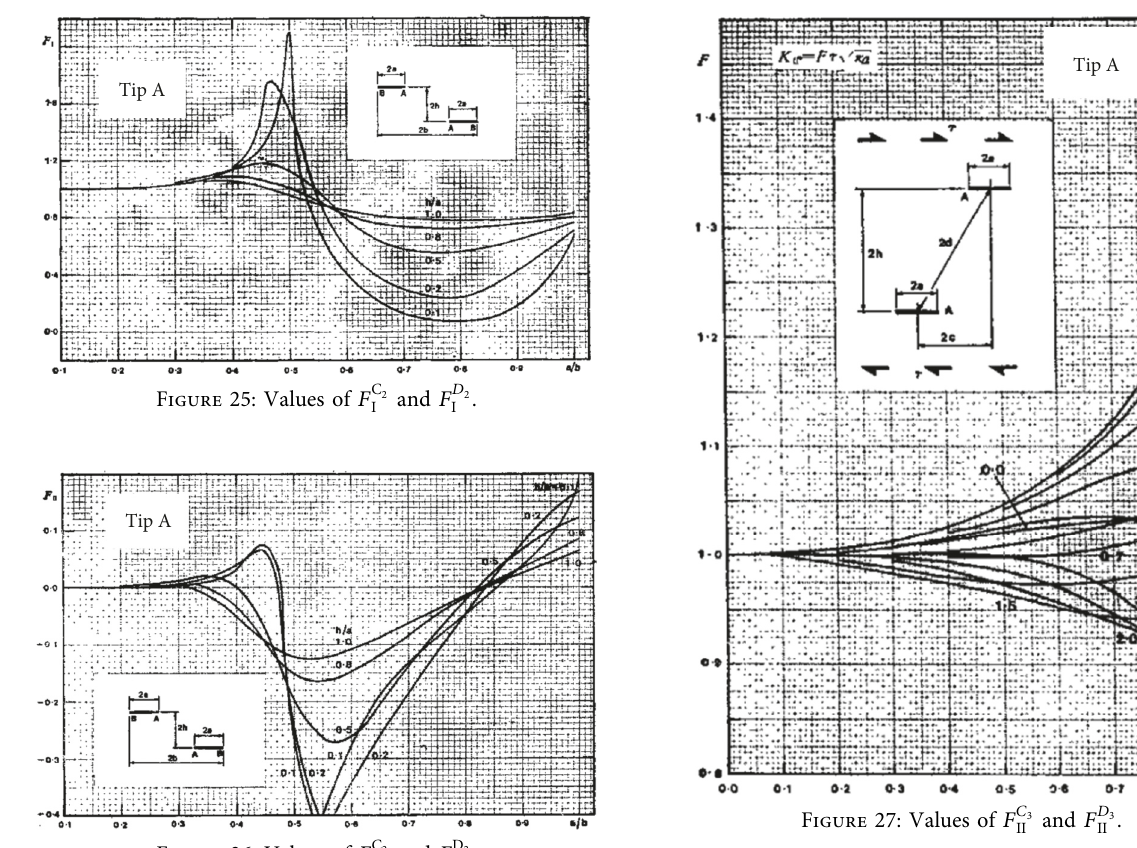
Figure 26: Values of F C 2